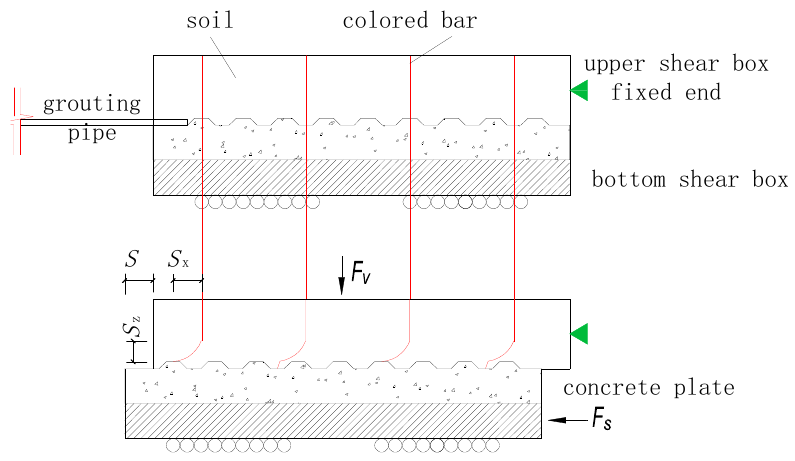
Figure 4. Distribution of colored bars in the upper shear box soil (units: mm).